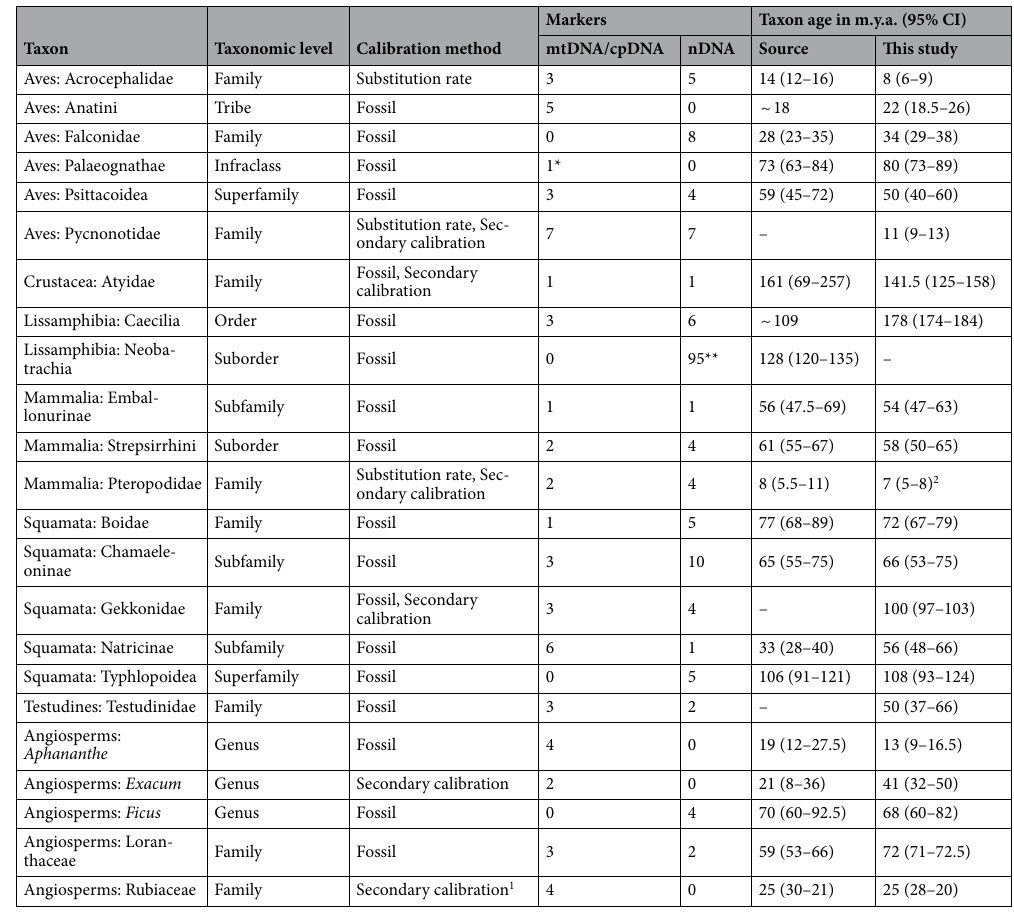
Table 1. Taxa included in this study with a summary of the calibration method for the molecular clock, type and number of markers used, divergences dates. Ages are the most recent common ancestor for the given taxon. References of the articles on which the analyses were based are available in the Appendix S0. Some of the analyses include data from other sources and these are specified in Appendix S2. *The marker used was the entire mitogenome; **This dataset was very large and, thus, we had to reduce and restrain it to set up the analysis (see Appendices); 1 To simplify the analysis, we separated the tribes that were present in diverse biogeographic regions (Coffeae, Bertiereae, Octotropideae, and Pavetteae) and built the trees independently; 2 Age of TMRCA between Pteropus and